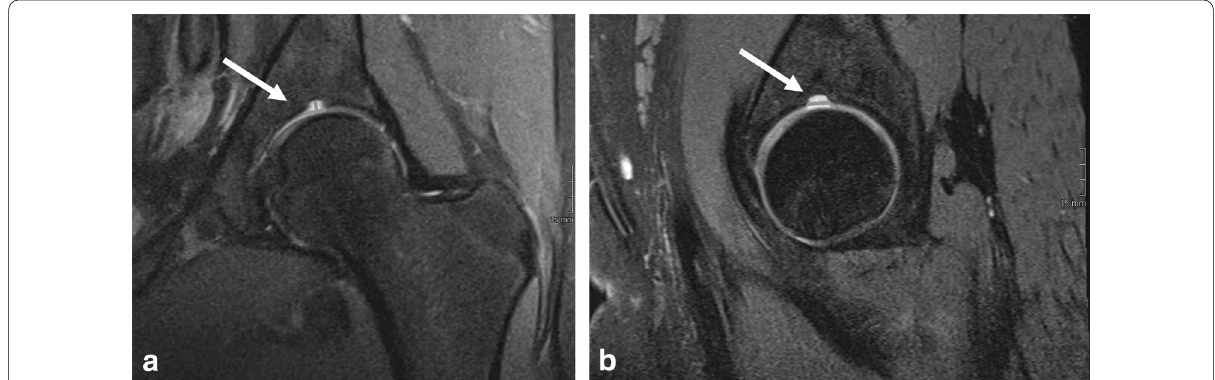
Fig. 1 An example of the placed calipers to perform the measurements on MRI without contrast of the left hip of a 16-years-old, female participant. Proton density weighted (PD) coronal ( a ) with calipers to measure height and width ( a ), PD sagittal ( b ) with calipers to measure depth ( b ). Dimensions were 6 mm (height), 3 mm (width) mm and 7 mm (depth) (white